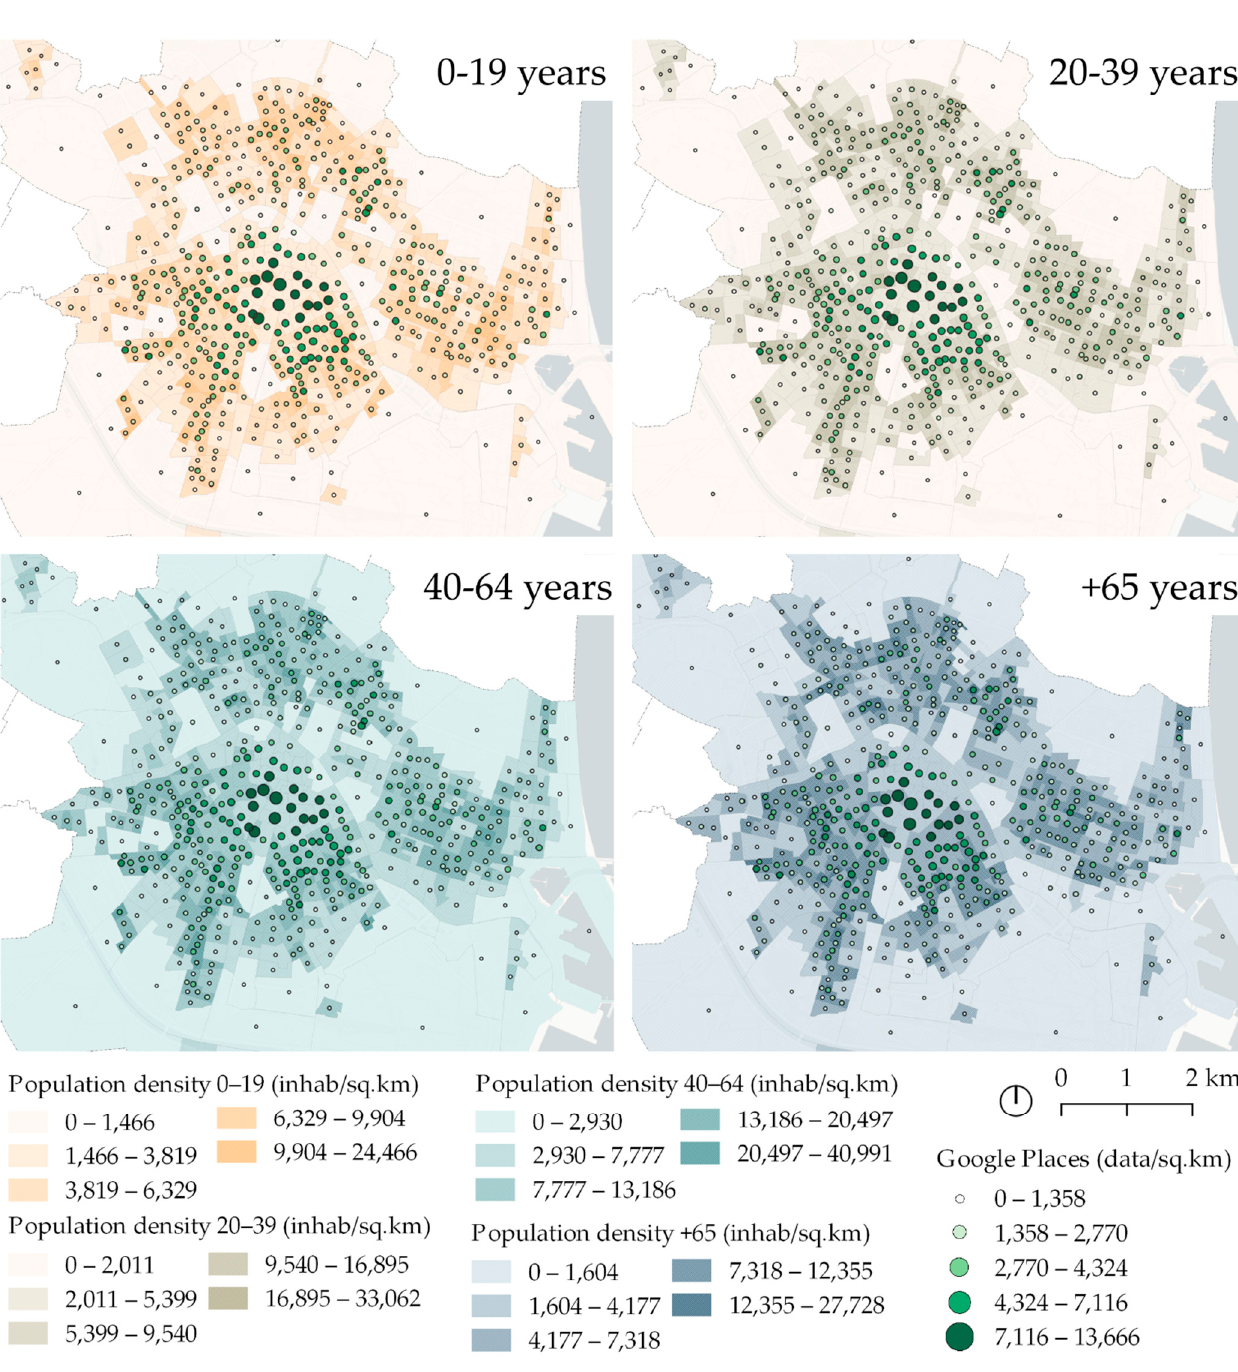
Figure 5. Population density per age group and Google Places data density.